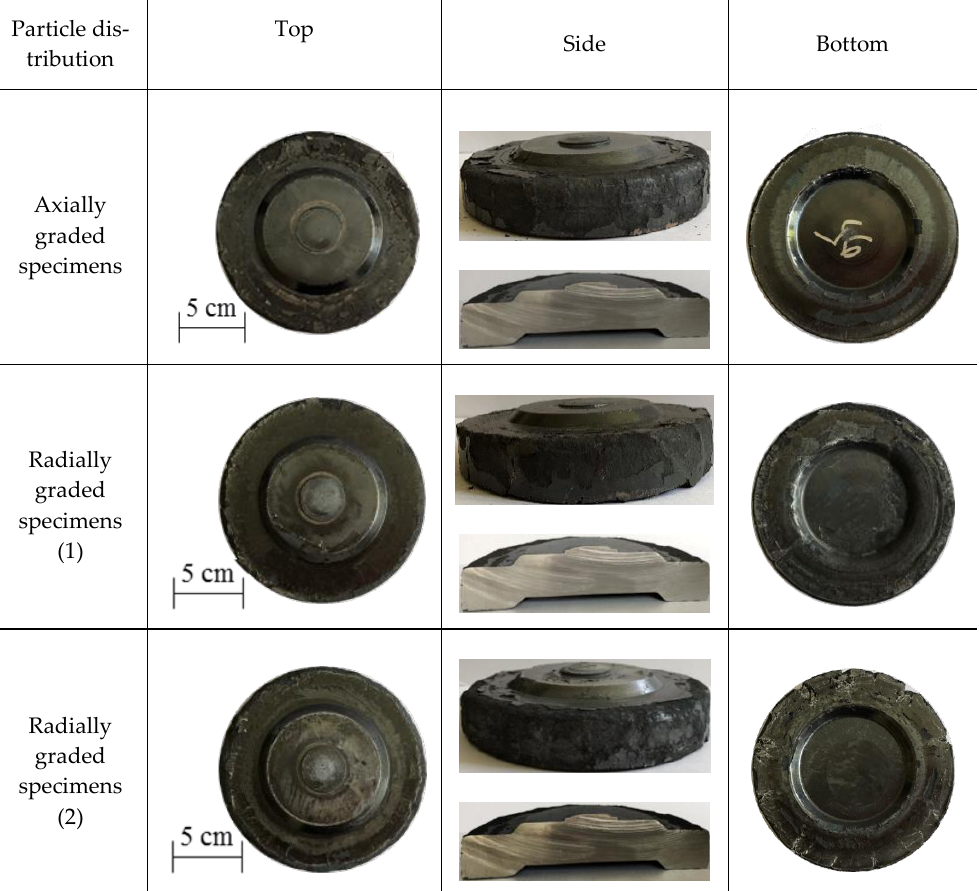
Figure 6. Specimen with an axially and radially graded ZrO 2 distribution.